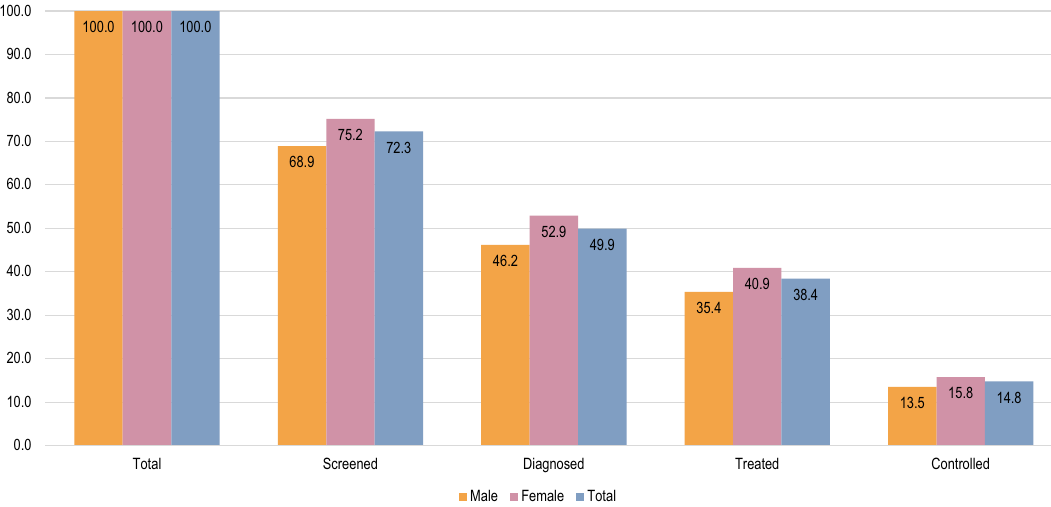
Figure 1. Hypertension care cascade by sex. Distribution of total, screened, diagnosed, treated and controlled hypertension care continuum by gender in percentage (denominator: hypertension population by each